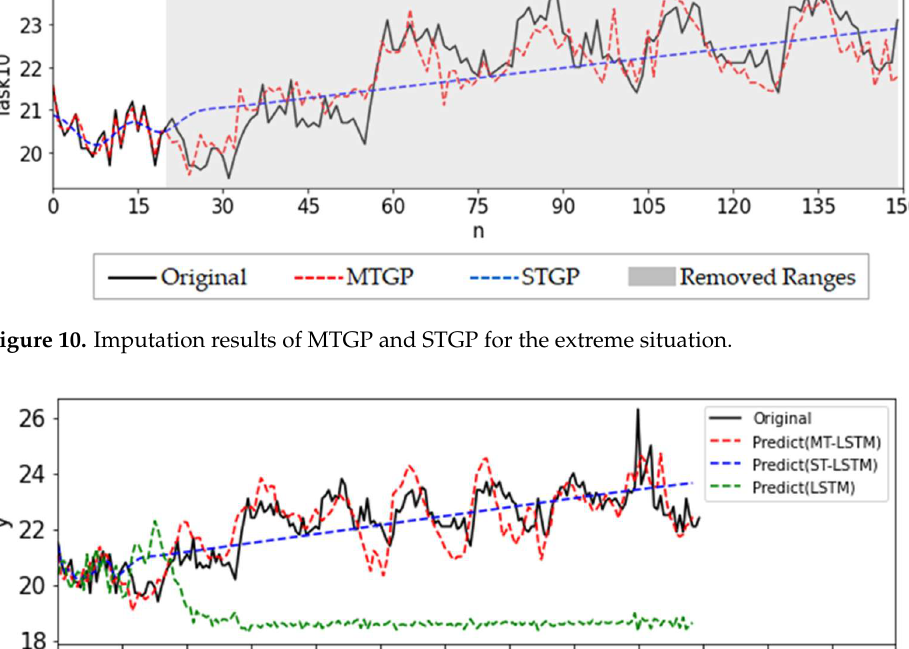
Table 7. Error results of MT-LSTM, ST-LSTM, and LSTM for the extreme situation.